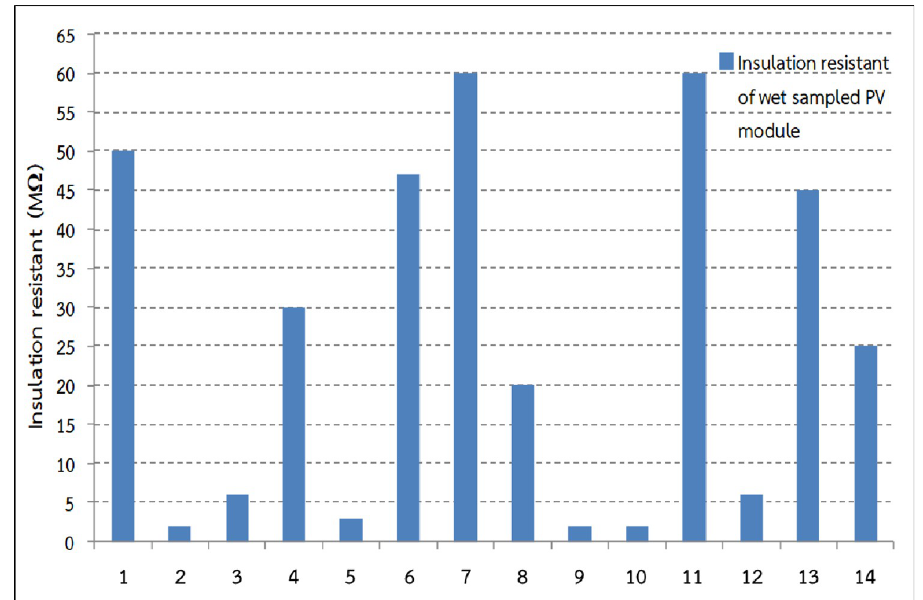
Fig 9. Insulation resistance of wet sampled PV